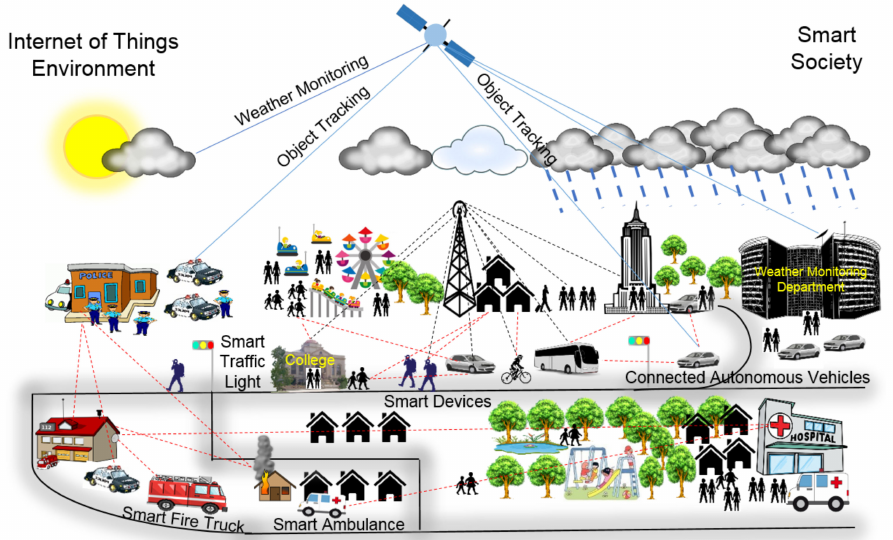
Figure 7. Smart city